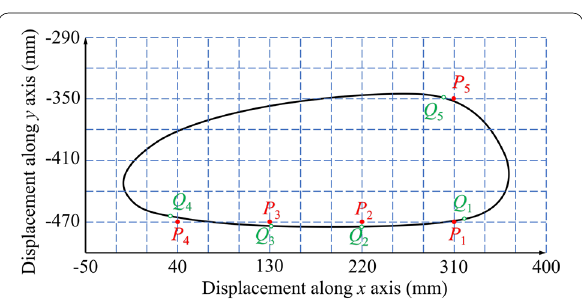
Figure 2 Optimal foot end point